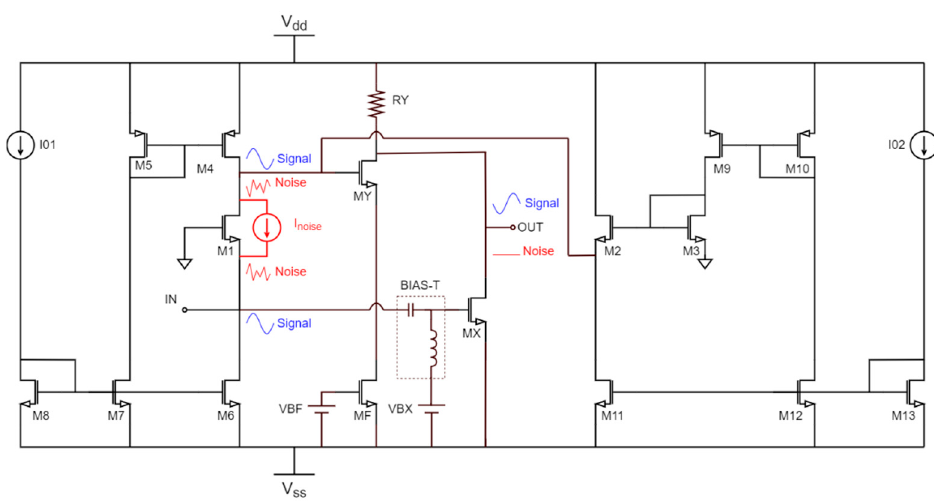
Figure 4. Proposed LNA based on current conveyors with noise canceling.